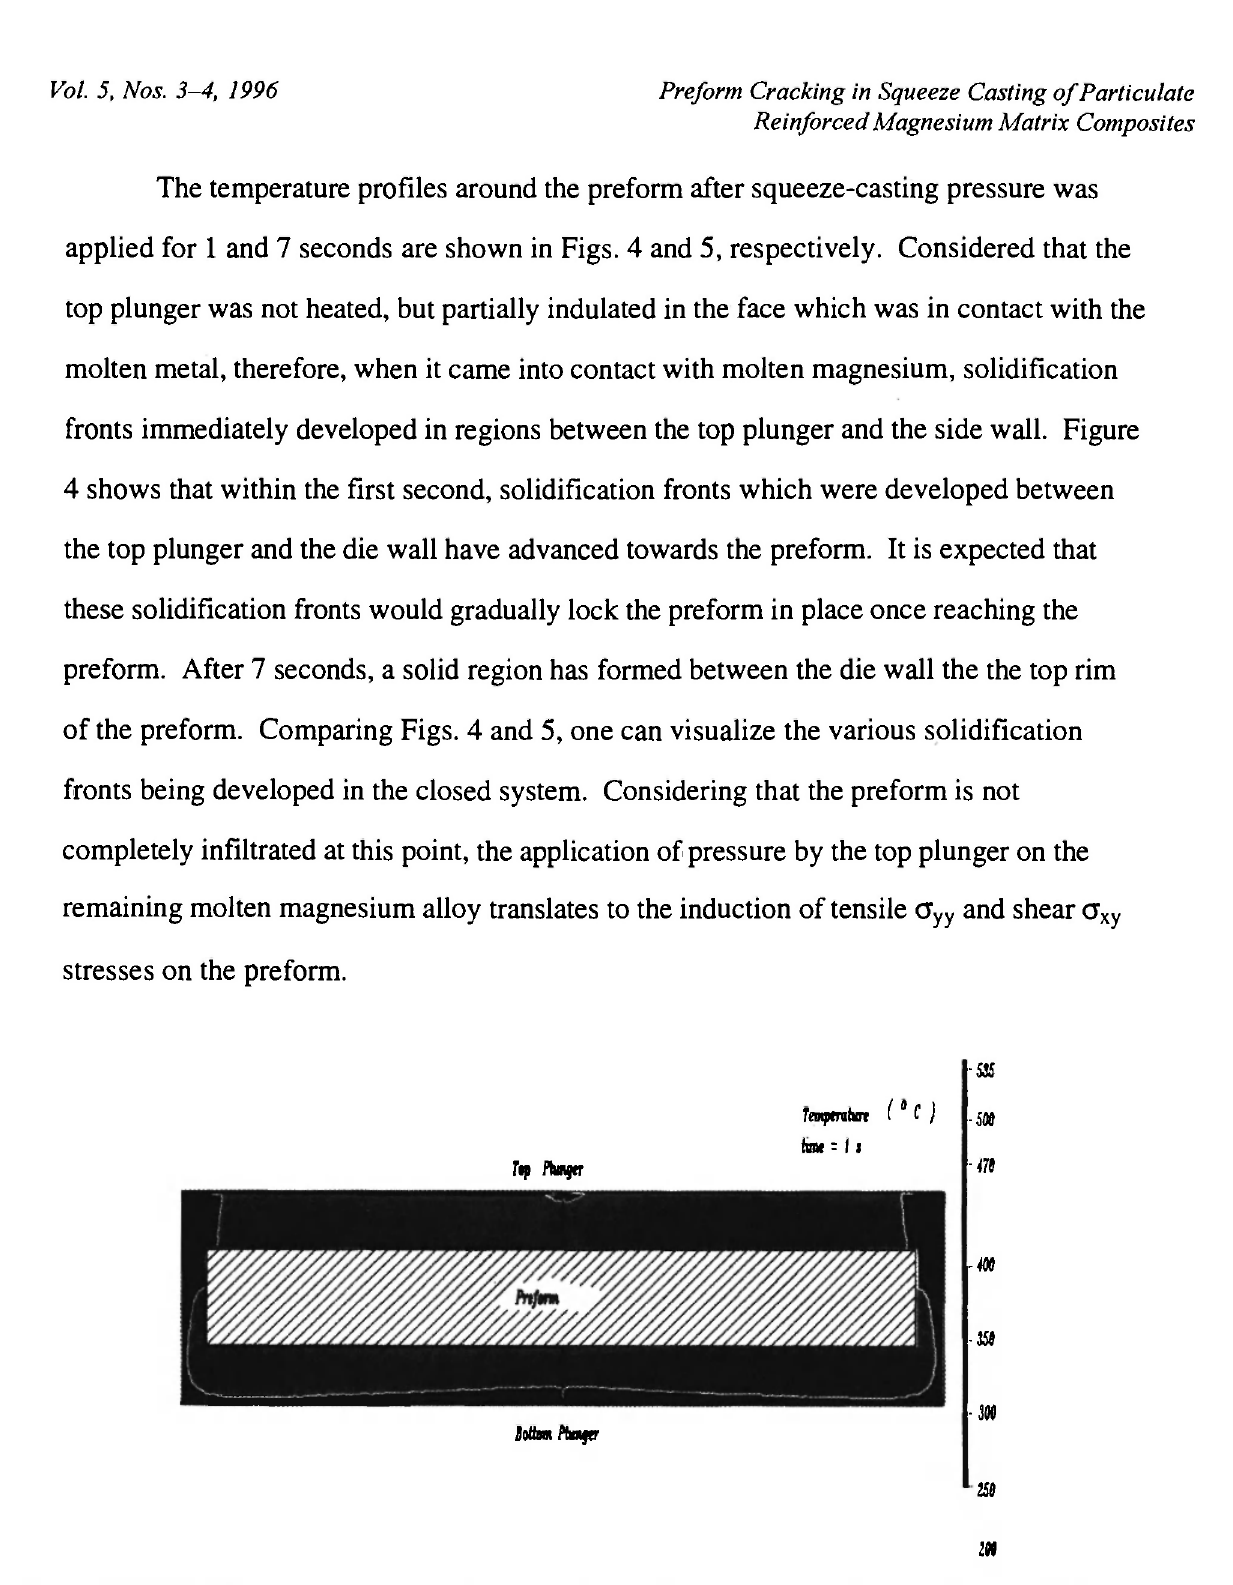
Figure 4. Modeled temperature profiles around a preform, one second after the magnesium melt was introduced and the squeeze-casting pressure of 120 MPa was applied. Since the middle regime of the top plunger was insulated, initial solidification began from regions between the die wall and top